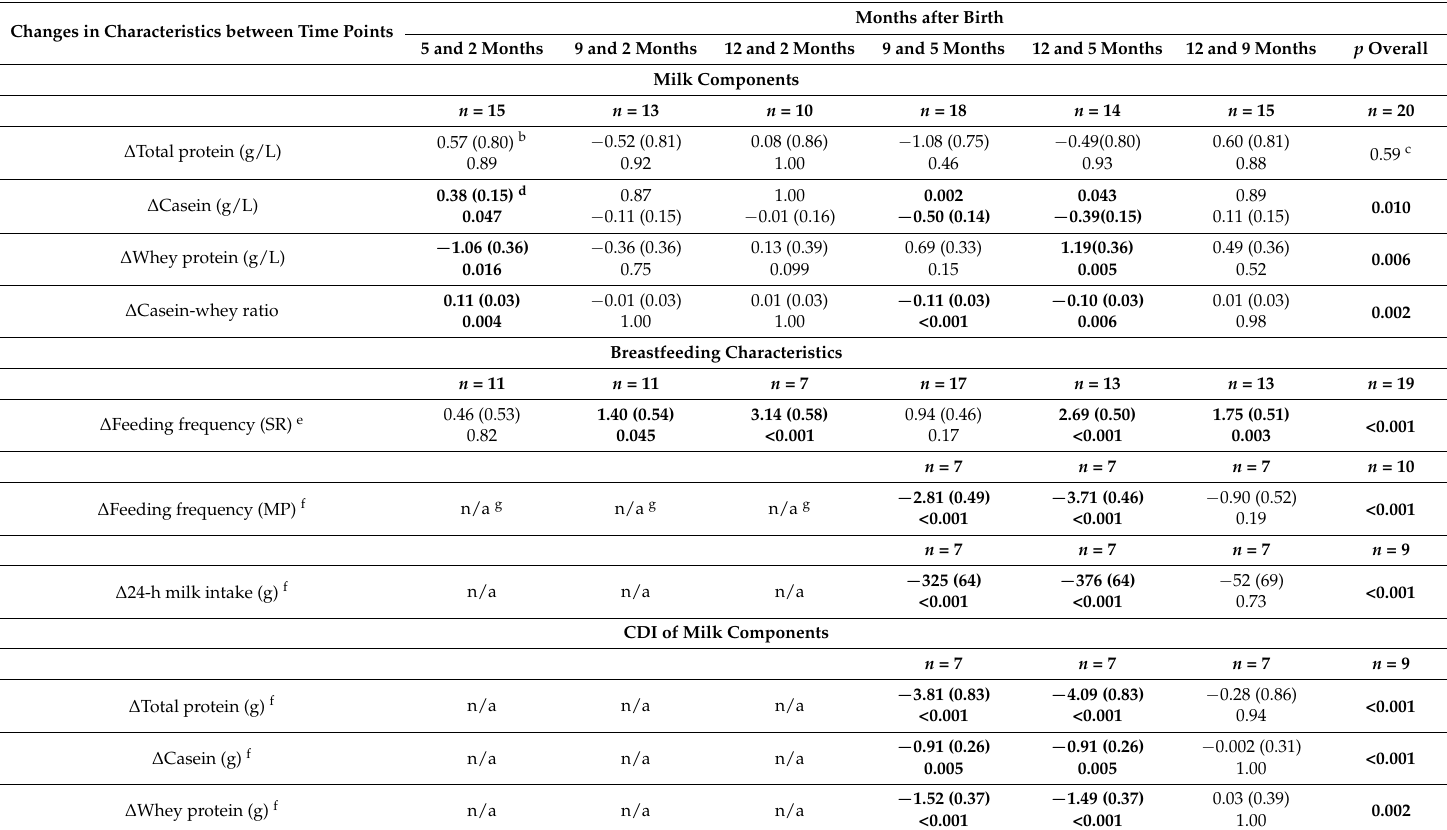
Table 4. Differences by infant age/lactation duration (between time points) within measured human milk proteins and breastfeeding parameters a . Changes in Characteristics between Time